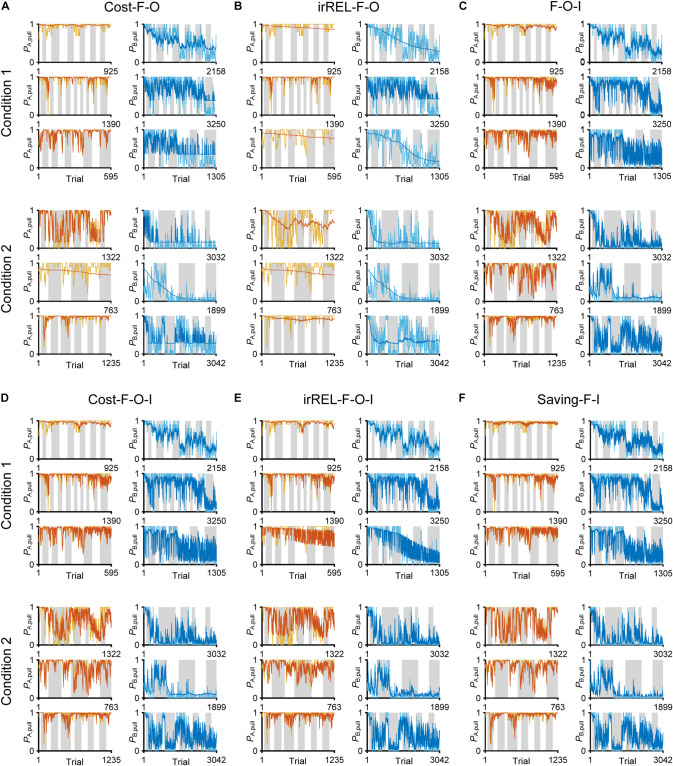
Choice-behaviors predicted by cost-F-O, irREL-F-O, F-O-I, cost-F-O-I, irREL-F-O-I, and saving-F-I models. Six representative predicted pull-choice probabilities of the models in tone A (left) and B (right) trials in conditions 1 (top three rows) and 2 (bottom three rows). Orange and cyan traces represent the 10-trial moving-average of the actual pull-choice (the same as in Figure 2). Red and blue traces represent the predicted pull-choice probability in cost-F-O (A), irREL-F-O (B), F-O-I (C), cost-F-O-I (D), irREL-F-O-I (E), and saving-F-I (F) models.